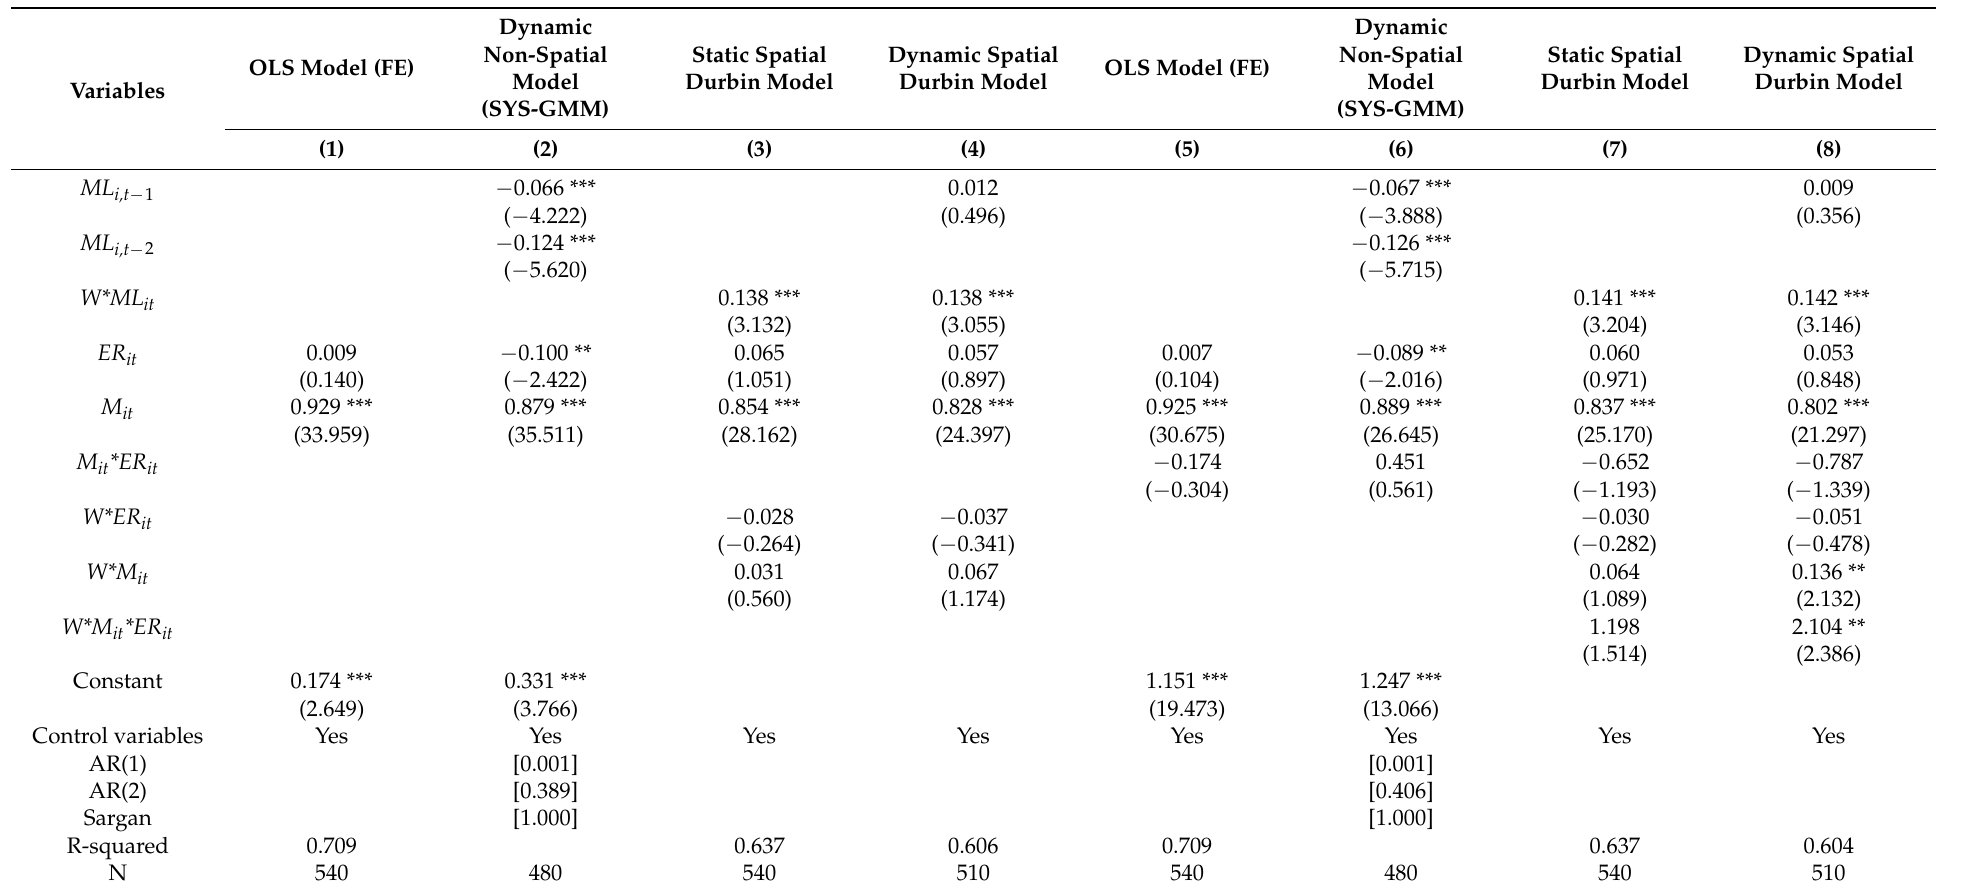
Table 6. The moderating results of technical change for the nexus between public-participation environmental regulation and green